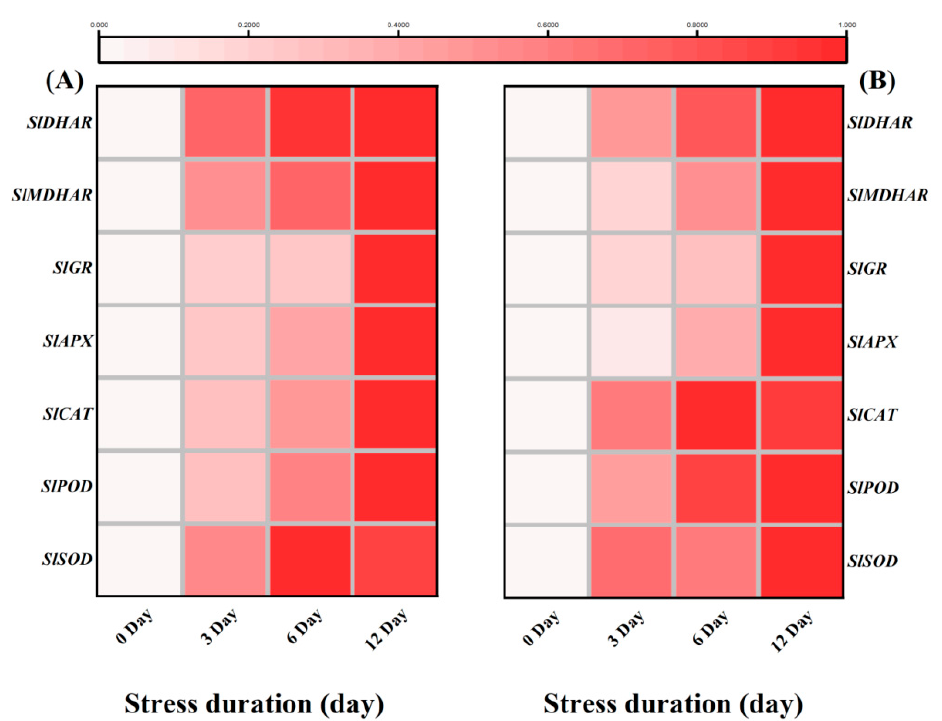
Figure 5. Effects of salt stress on antioxidant enzymes ( A ) superoxide dismutase SOD; ( B ) peroxidase POD; ( C ) catalase CAT; ( D ) ascorbate peroxidase APX; ( E ) glutathione reductase GR; ( F ) monodehy- droascorbate reductase MDHAR; ( G ) dehydroascorbate reductase DHAR; ( H ) MDAR; in tomato leaves seedlings grown for 12 days under control and salt stress. Values are mean ± SD (Standard Deviation) of three replications. Different letters indicate significant differences at p ≤ 0.05 (Tukey’s HSD test).